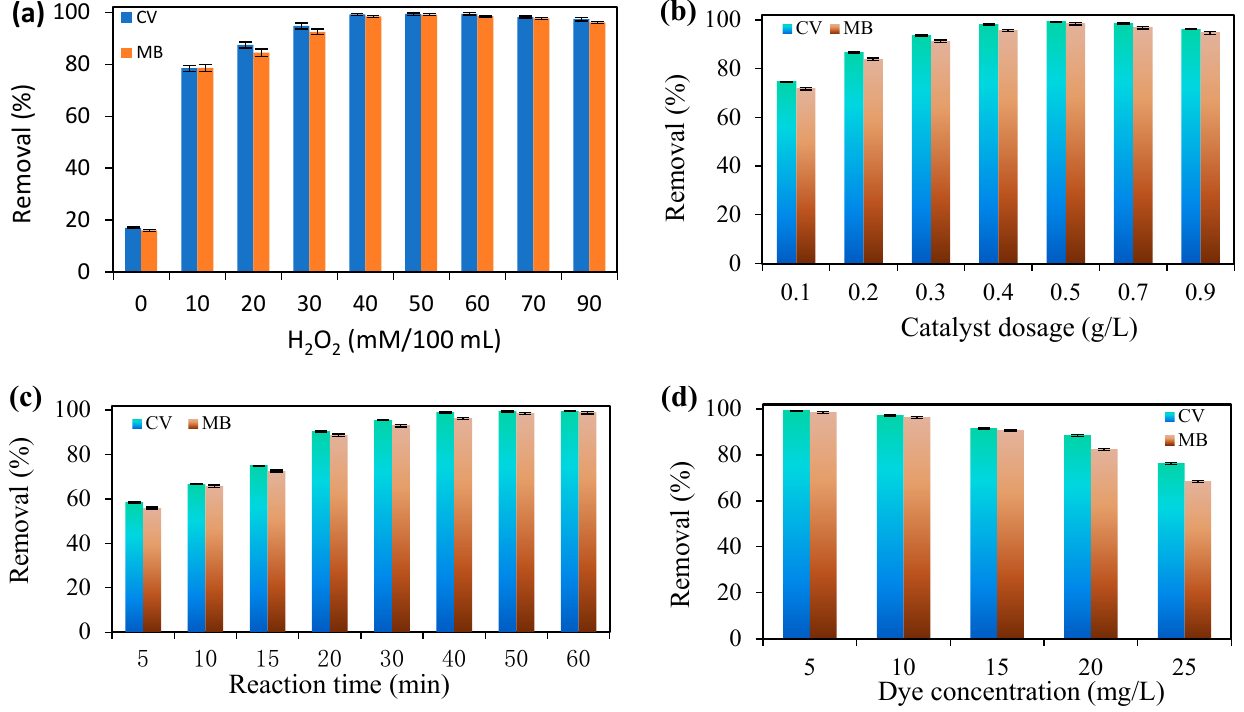
Figure 7. ( a ) Effect of amount of H 2 O 2 (concentration of dyes 5 mg/L, reaction time 50 min, catalyst dose 0.5 g/L and pH = 8), ( b ) Effect of catalyst dose (initial concentration of dyes 5 mg/L, reaction time 50 min, amount of H 2 O 2 40 mM/100 mL and pH = 8), ( c ) effect of reaction time (initial concentration of dyes 5 mg/L, dose of catalyst 0.5 g/L, amount of H 2 O 2 40 mM/100 mL and pH = 8), and ( d ) the effect of the dyes concentration (catalyst dose 0.5 g/L, reaction time 50 min, amount of H 2 O 2 40 mM/100 mL and pH = 8) on the dye removal using Cloisite 30B/ZnO/Ag 2 O.